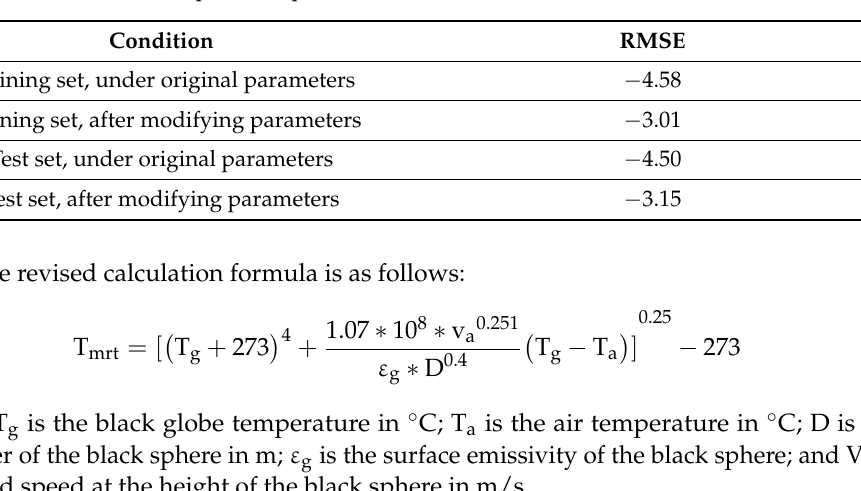
Table 8. The situation description of optimization